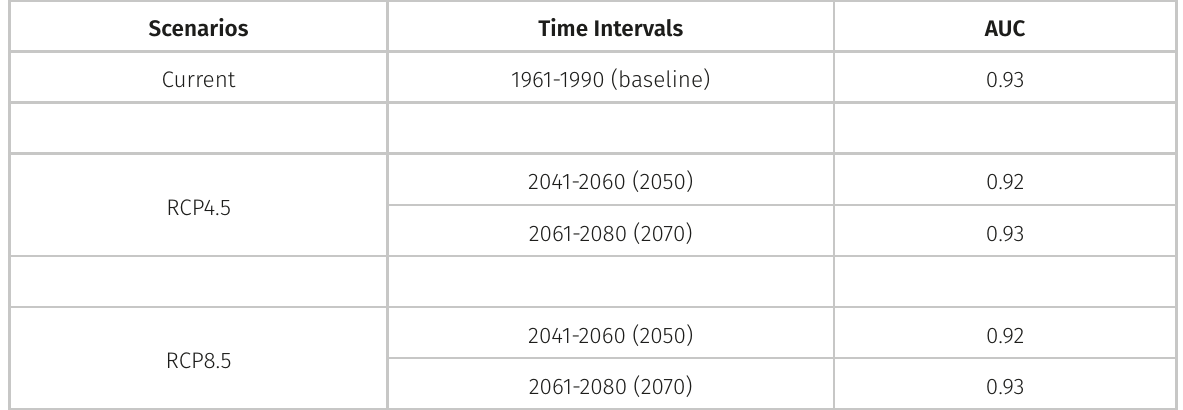
Table I. AUC values of the final models.